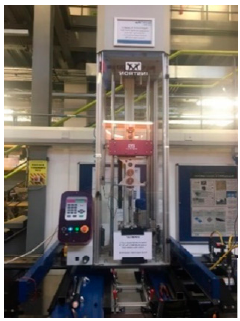
Figure 12. INSTON CEAST 9350 drop tower.